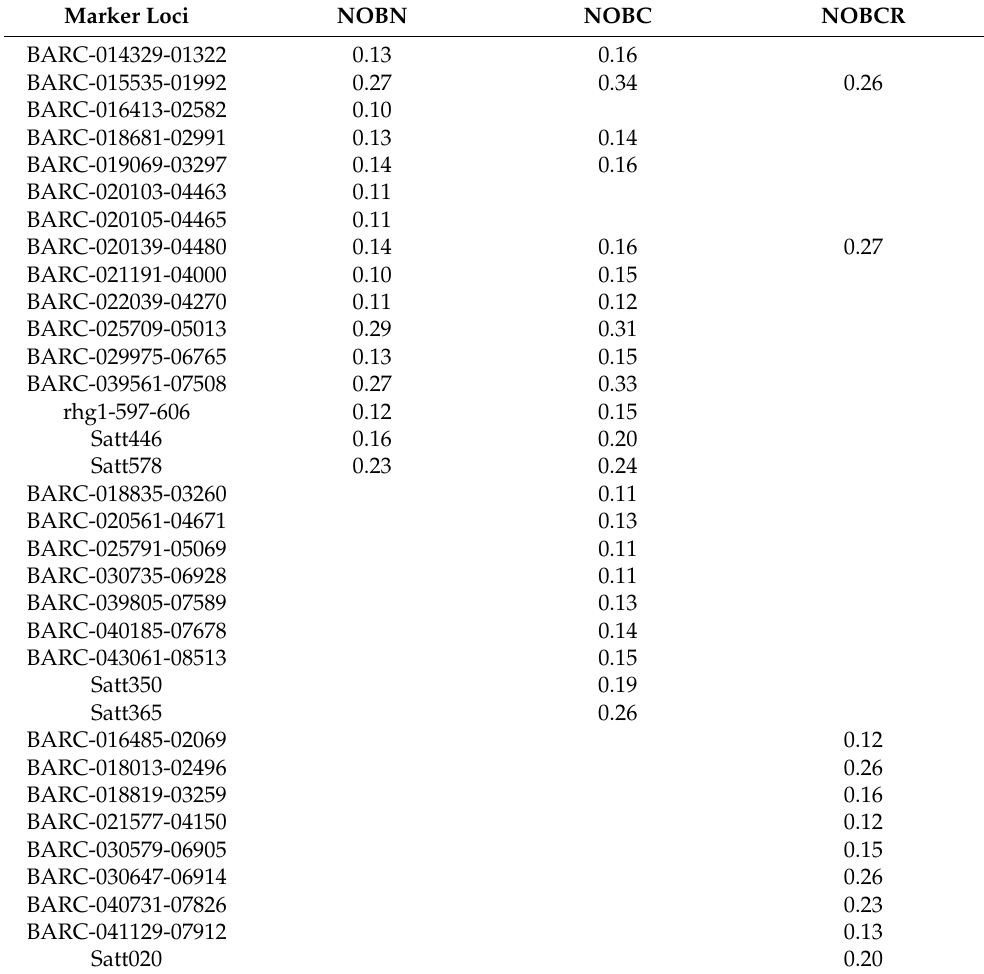
Table 4. Marker loci associated with the number of bean pods and its trait variation in low-light, along with the explanation rates of different